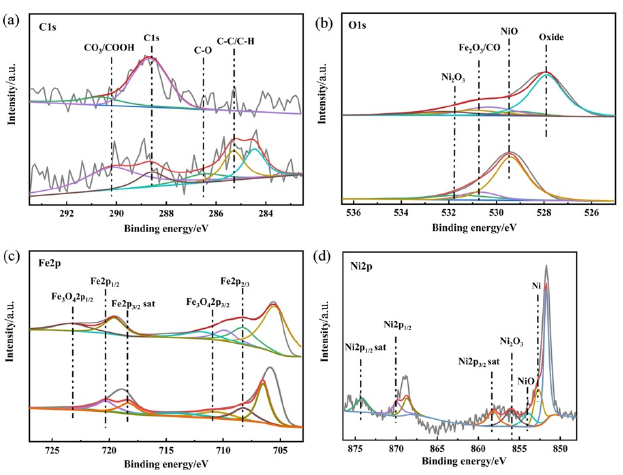
Figure 9. XPS spectra of ( a ) C1s, ( b ) O1s, ( c ) Fe2p, and ( d ) Ni2p on the worn scars of steel balls lubricated by pure lithium grease and 0.2 wt% Ni-doped lithium grease after four-ball tribology